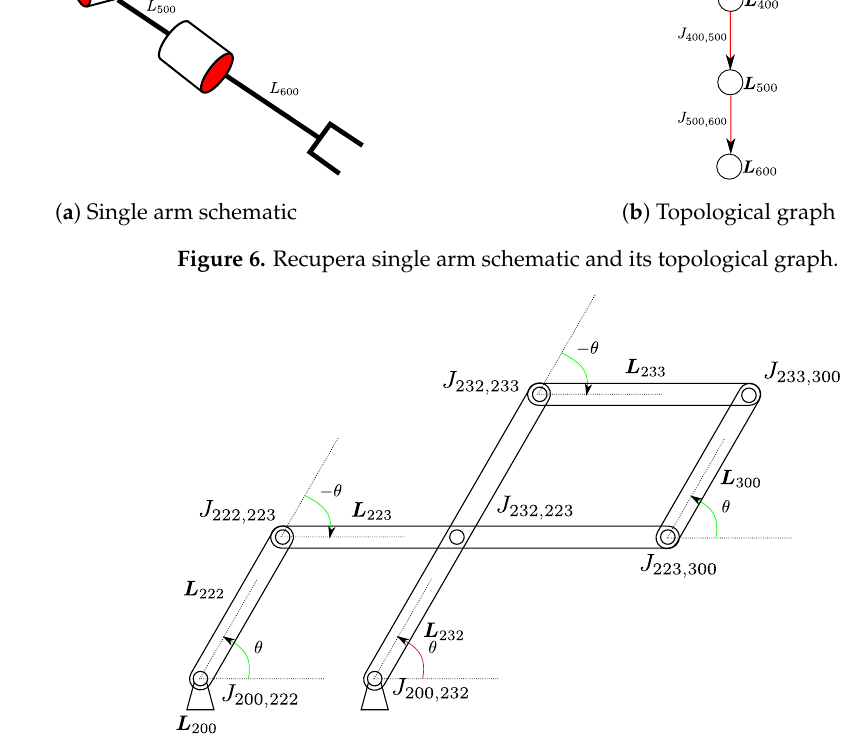
Figure 7. Double parallelogram